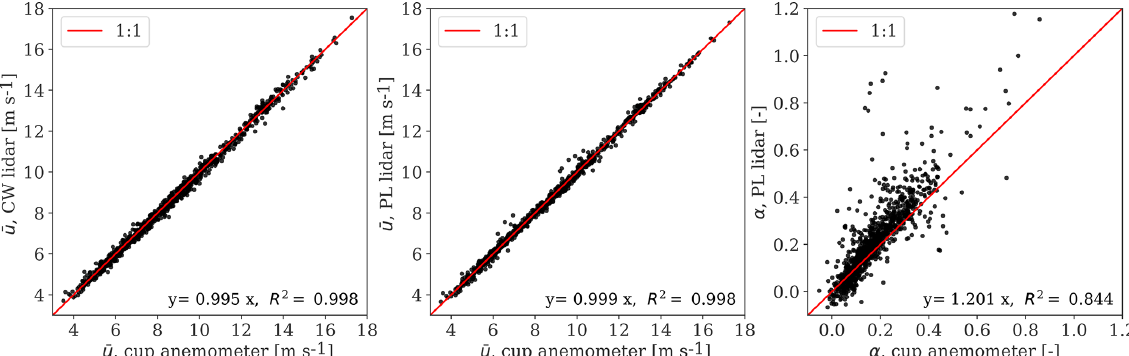
Figure 3. Comparison of 10min lidar-estimated and mast-measured inflow characteristics. We show a 1 : 1 line for guidance, the slope of a linear regression model and the coefficient of determination R 2 .